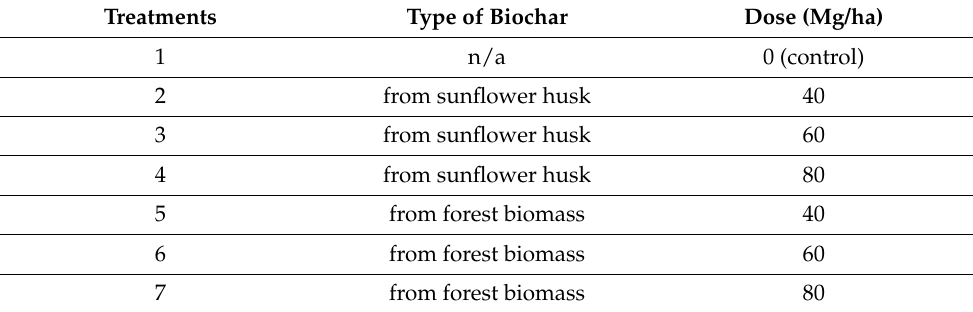
Table 1. The scheme of the vegetation experiment. Treatments Type of Biochar Dose (Mg/ha) from sunflower husk from sunflower husk from forest biomass from forest biomass 7 from forest biomass